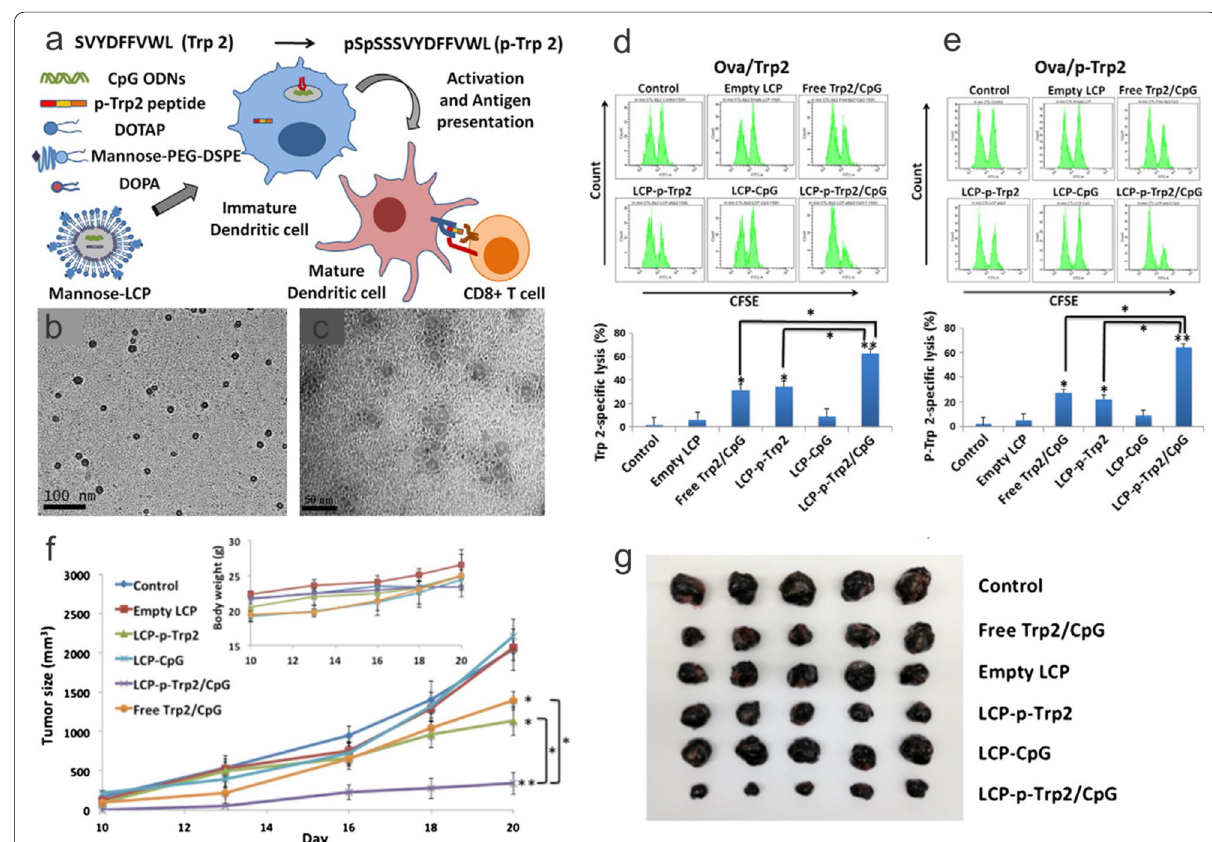
Fig. 3 Lipid calcium phosphate nanoparticle (LCP NP)‑mediated co‑delivery of Trp2 peptide and CpG in B16F10 subcutaneous tumor. a Synthesis LCP NPs that encapsulate phosphorylated Trp2 (p‑Trp2 ) and CpG for the delivery into DCs via the mannose receptor. TEM image of b hydrophobic LCP cores and c mannose‑functionalized, aqueous LCP NPs. In vivo CTL response assay examining mice immunized with control peptide/CpG or mannose‑LCP NPs containing both Trp2/CpG against splenocytes pulsed with d Trp2 or e p‑Trp2. f , g Reduction of B16F10 tumor sizes in mice immunized with LCP NPs containing both Trp2 and CpG. Reproduced with permission from ref